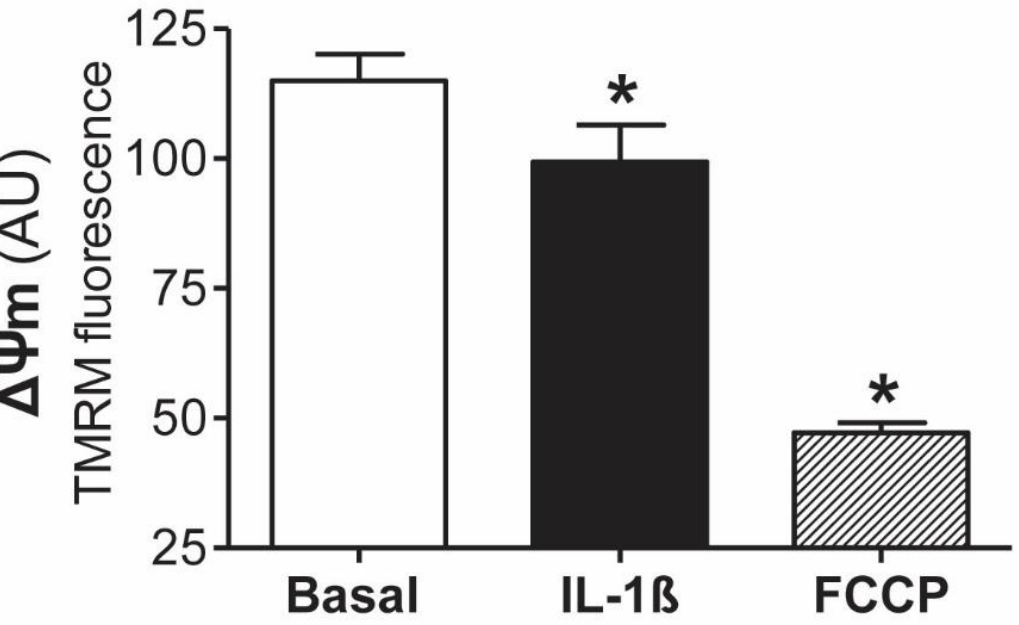
Figure 1. IL-1 β induces mitochondrial depolarization in effluent-derived human mesothelial cells. Mitochondrial depolarization was assayed in mesothelial cells with epithelial phenotypes derived from peritoneal equilibration test (PET) samples stimulated for 12 h with IL-1 β and loaded with tetramethylrhodamine methyl ester (TMRM) for 30 min before the end of incubation. Fluorescence quantification for TMRM (n = 7) is expressed as the mean ± SEM of fluorescence intensity in arbitrary units (AU). * p ≤ 0.05 vs. basal.